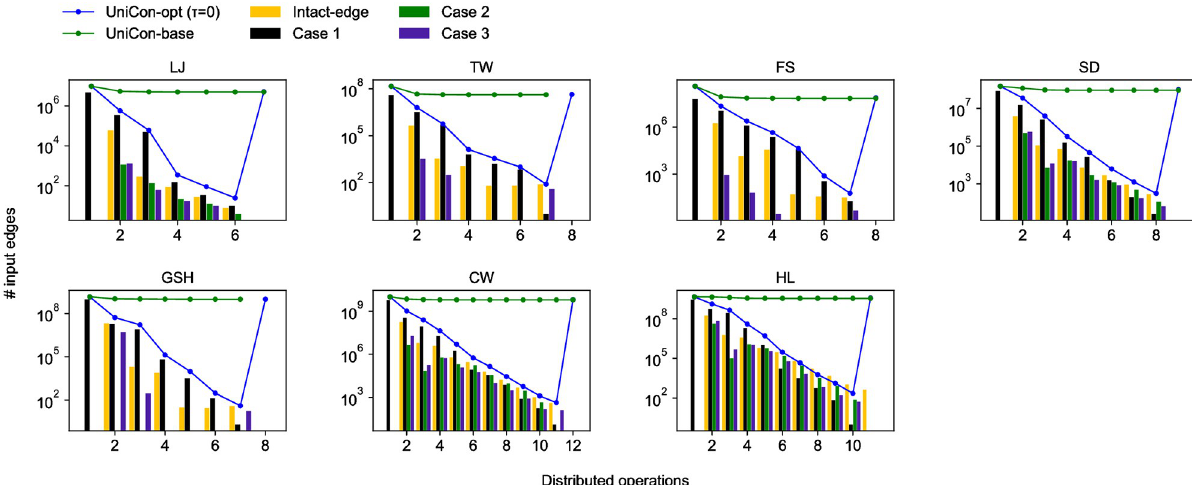
Fig 10. The number of input edges (denoted by lines) for UniCon-opt ( τ = 0) and UniCon-base each round. Filtering dispensable edges (denoted by bars), UniCon-opt shrinks the input size by 80.4% on average every round on CW.